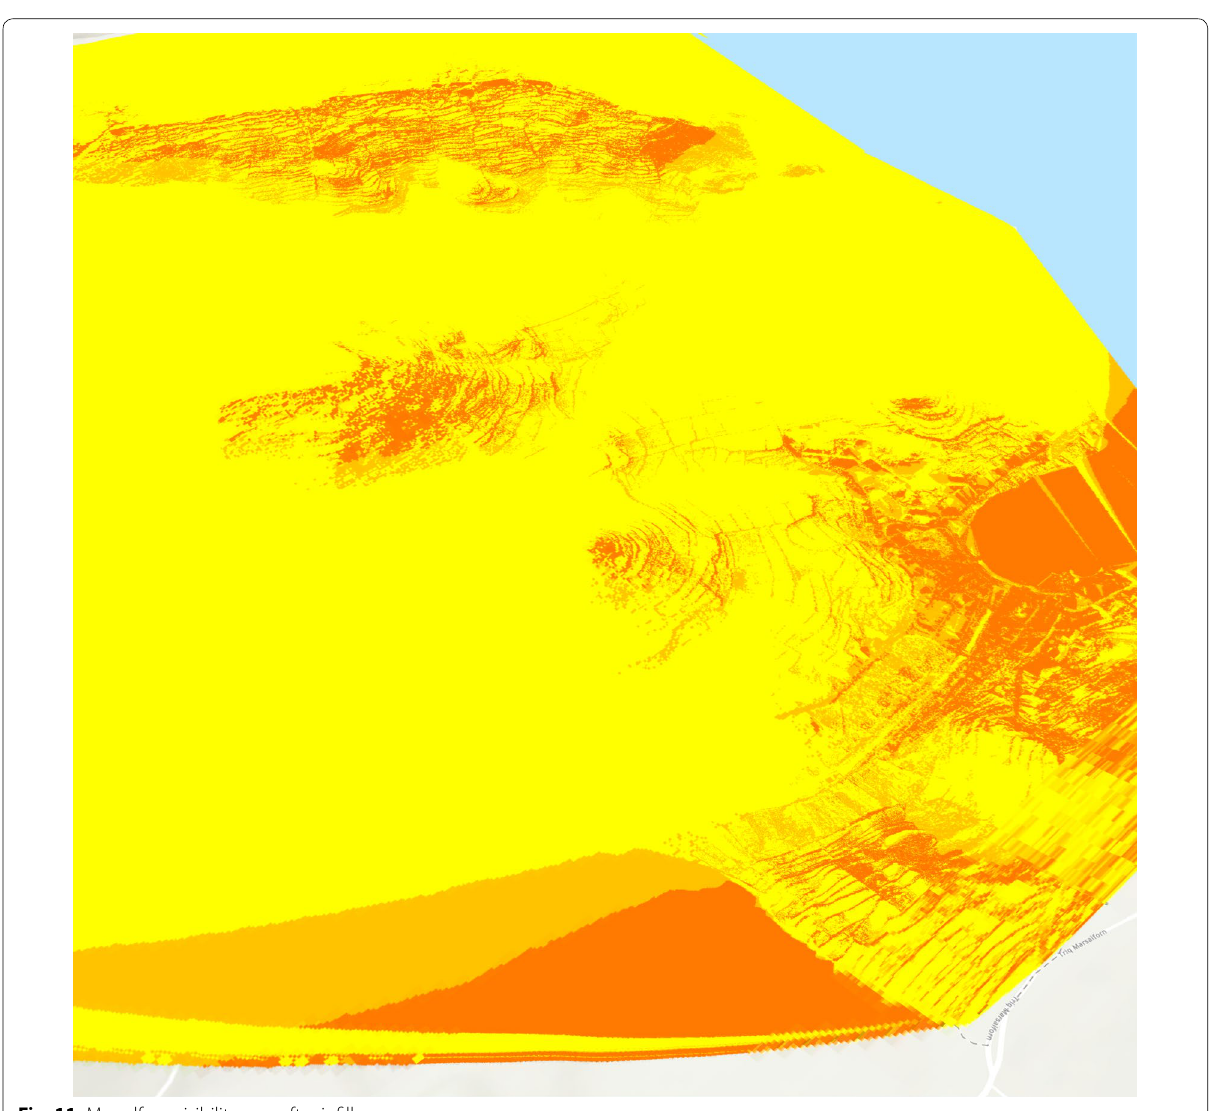
Fig. 11 Marsalforn visibility area after